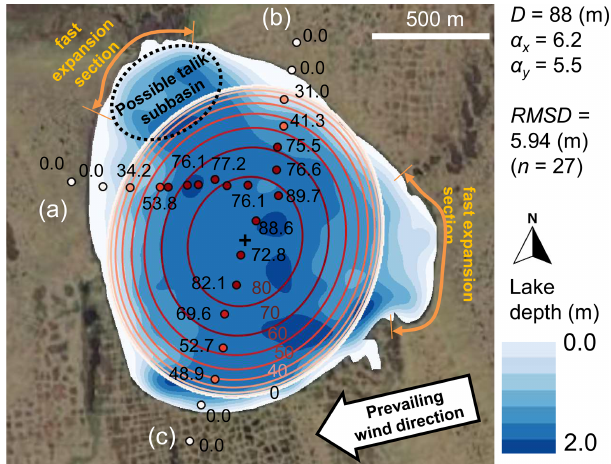
Figure 4. The theoretically extrapolated talik thickness map (con- tour lines) based on 27 TEM soundings (dots) in Peatball Lake, ACP of Alaska. The red contour lines and the observation points are consistent. The corresponding observed lake bathymetry (adopted from Lenz et al., 2016) is also included in blue gradation. The TEM sounding transects start on the lakeshore and end near the center of the